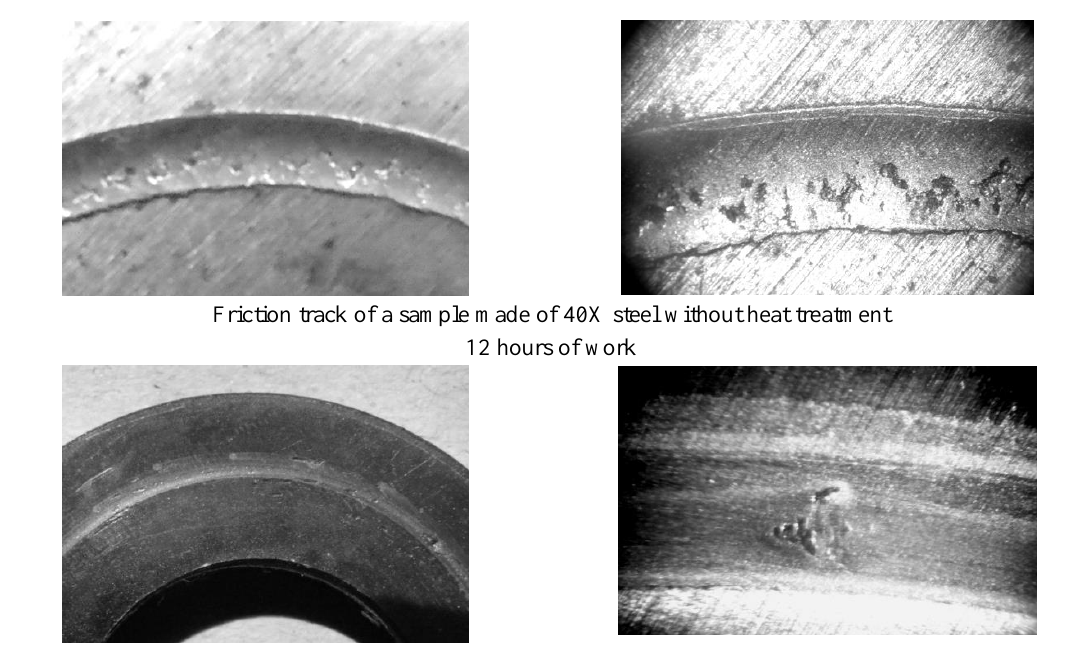
Fig. 1. Comparison of the friction paths of 40X steel samples without heat treatment and after nitriding, during friction in I-20